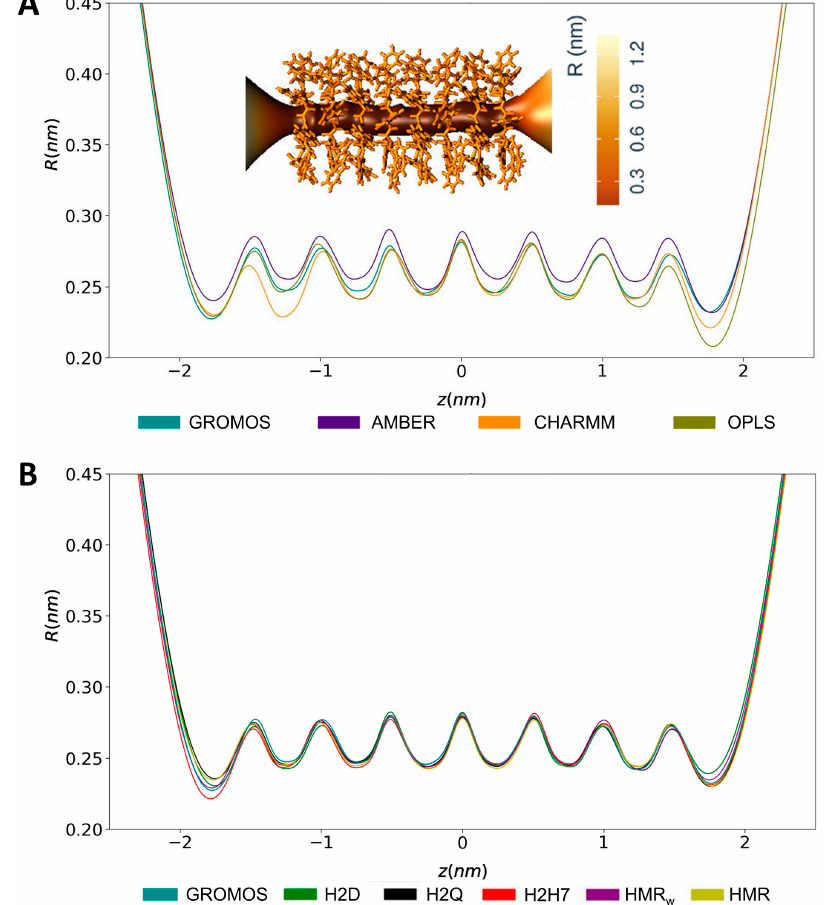
Figure 7. Inner radius (nm) of the SCPN calculated with CHAP [72] throughout the MD simulations, using the different the force fields ( A ) and modified parameterizations of GROMOS based on hydrogen mass repartition/increase ( B ).